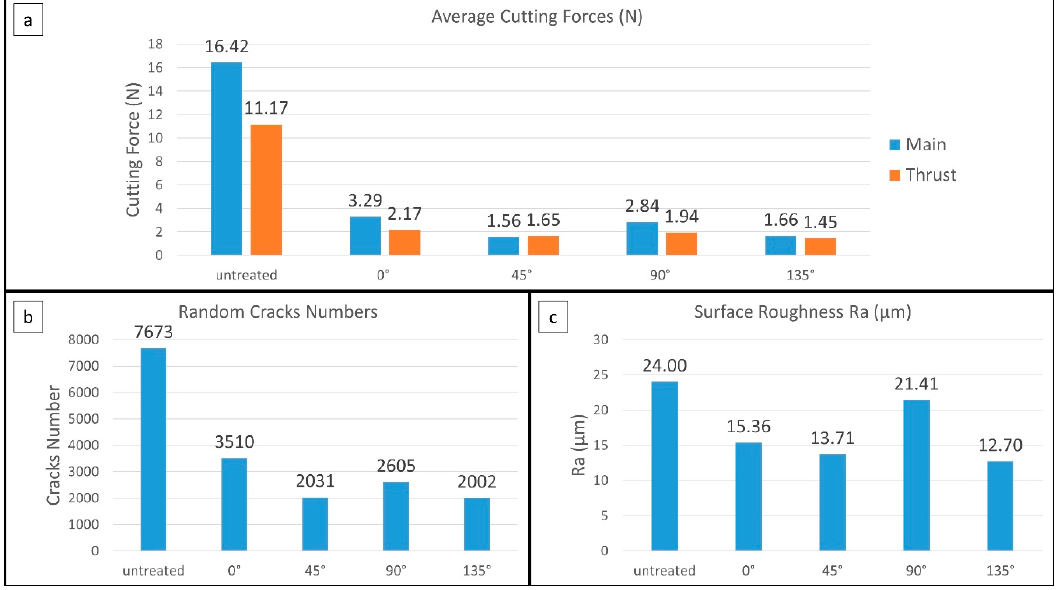
Figure 8. The simulation results for four different conditions: ( a ) Average cutting forces, ( b ) average random cracks, and ( c ) average surface roughness.